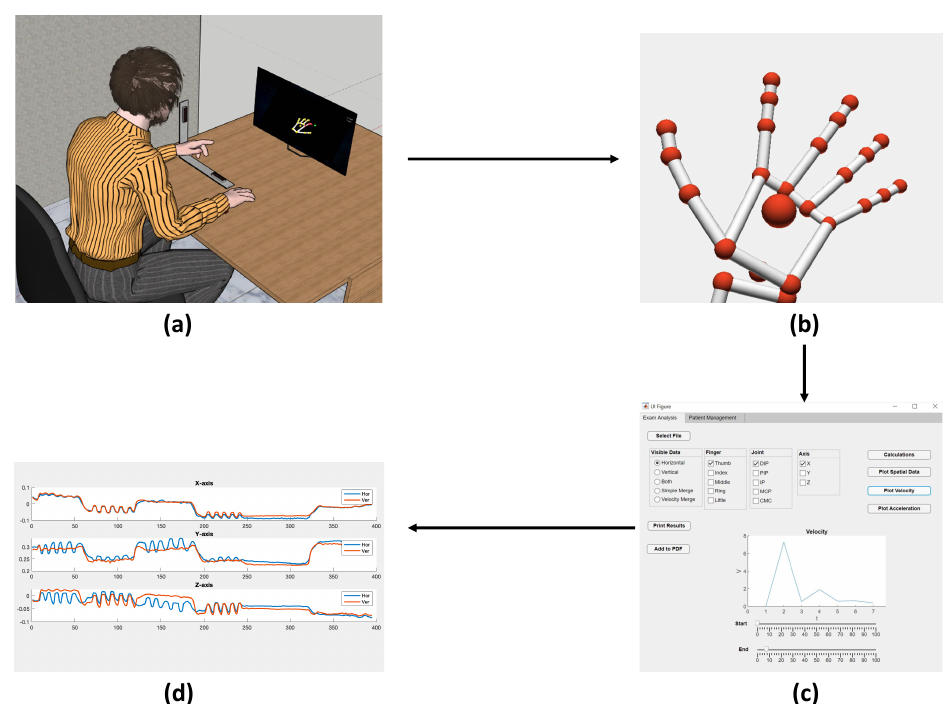
Figure 8. VG Data-flow pipeline. Here, one can see ( a ) the Patient performing a task, ( b ) the generated hand model, ( c ) the Therapist’s interface for data analysis and visualization, and ( d ) created plots presenting joint movement. The associated colors and the respective legend in ( d ) are irrelevant for the purpose of this paper: they just serve to show the general structure of the